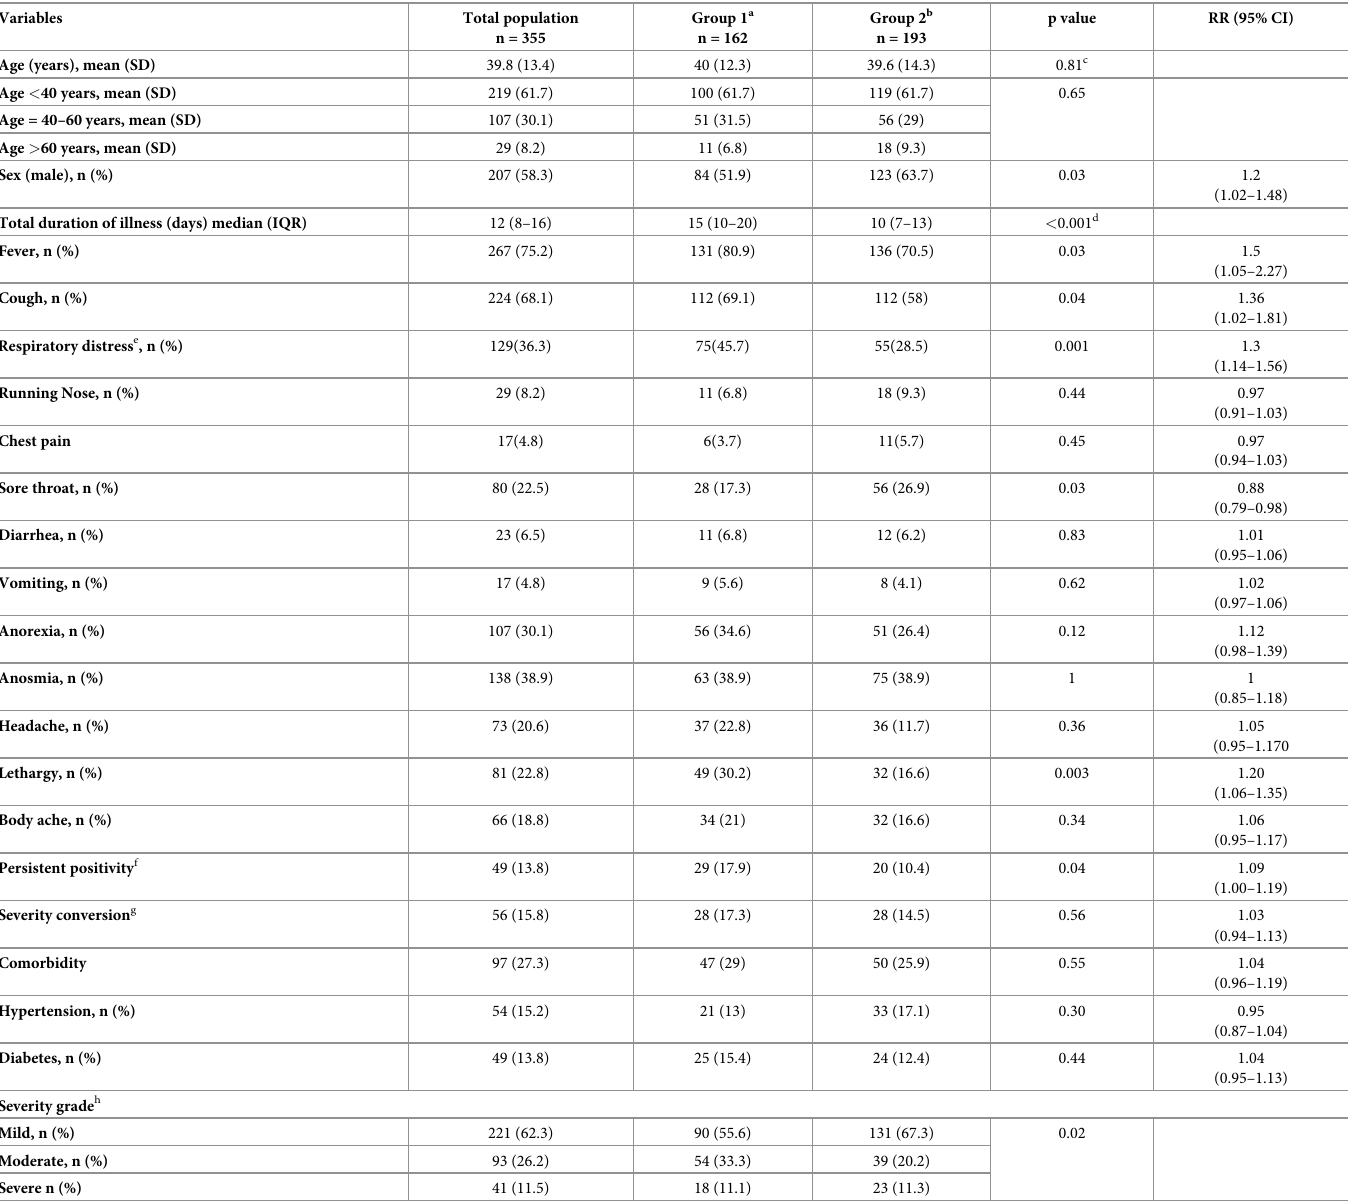
Table 1. Baseline characteristics of COVID-19 patients with or without post-COVID-19